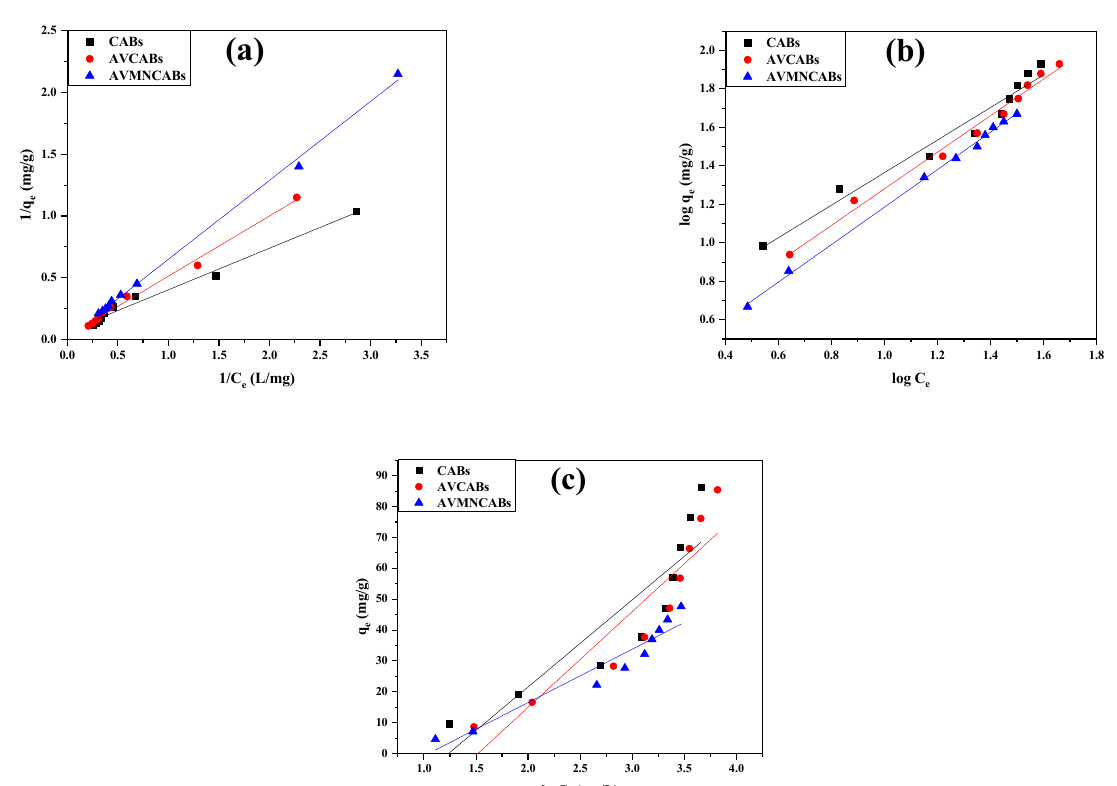
Figure 13. Adsorption isotherms: ( a ) Langmuir, ( b ) Frendlich, and ( c ) Temkin for CABs, AVCABs, and AVMNCABs.